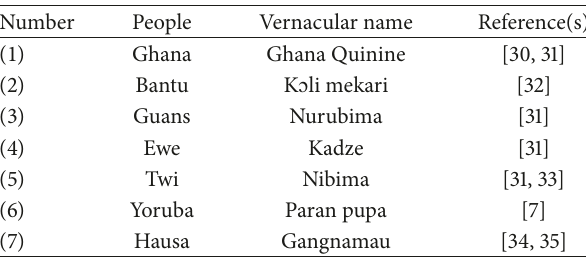
Table 2: Vernacular names of Cryptolepis sanguinolenta .